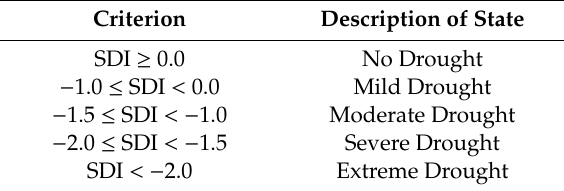
Table 2. Definition of states of hydrological drought with the streamflow drought index (SDI)